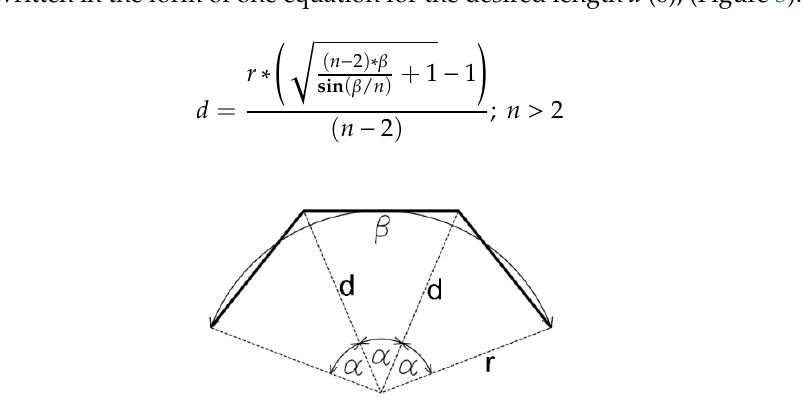
Figure 3. Changing the arc to polygon, n = 3.